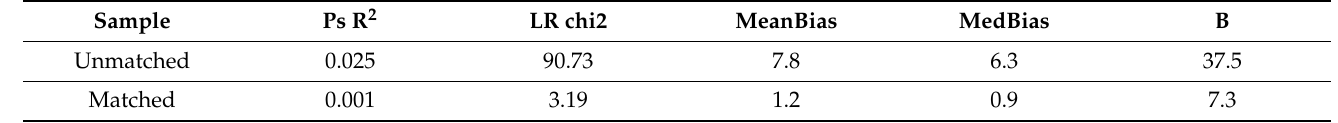
Table 6. Results of the joint test of the balance of matching variables before and after matching.